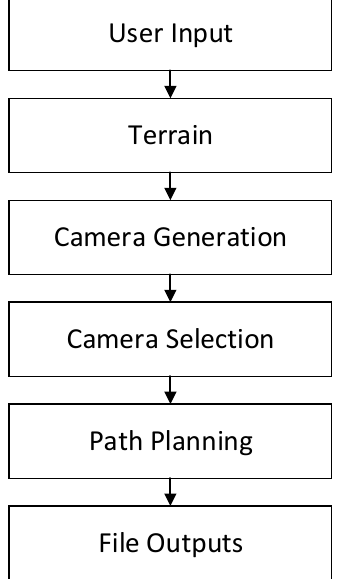
Figure 1. Overall workflow for iterative view planning.